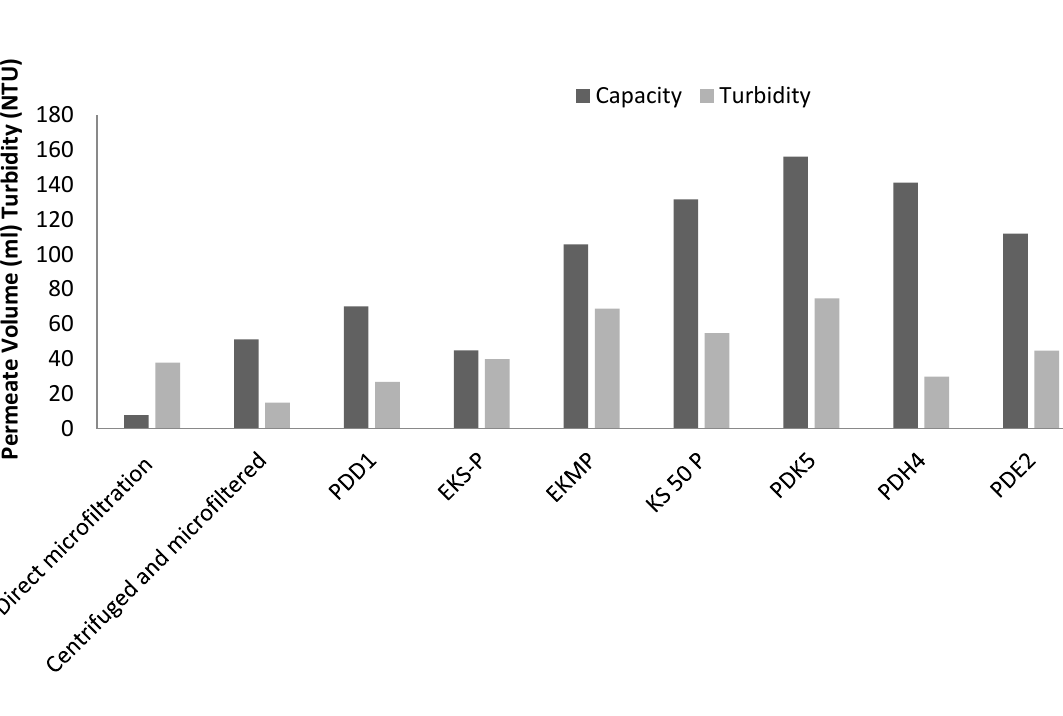
Figure 3. Comparison of capacity and turbidity of the micro filter and depth filters.